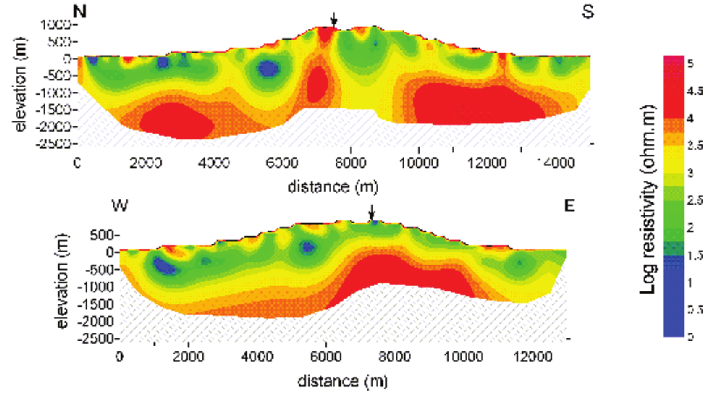
Fig. 2. 2D resistivity models across the N-S and E-W shallow DD ERT profiles (green straight lines in fig. 1). Black arrows indicate the profiles